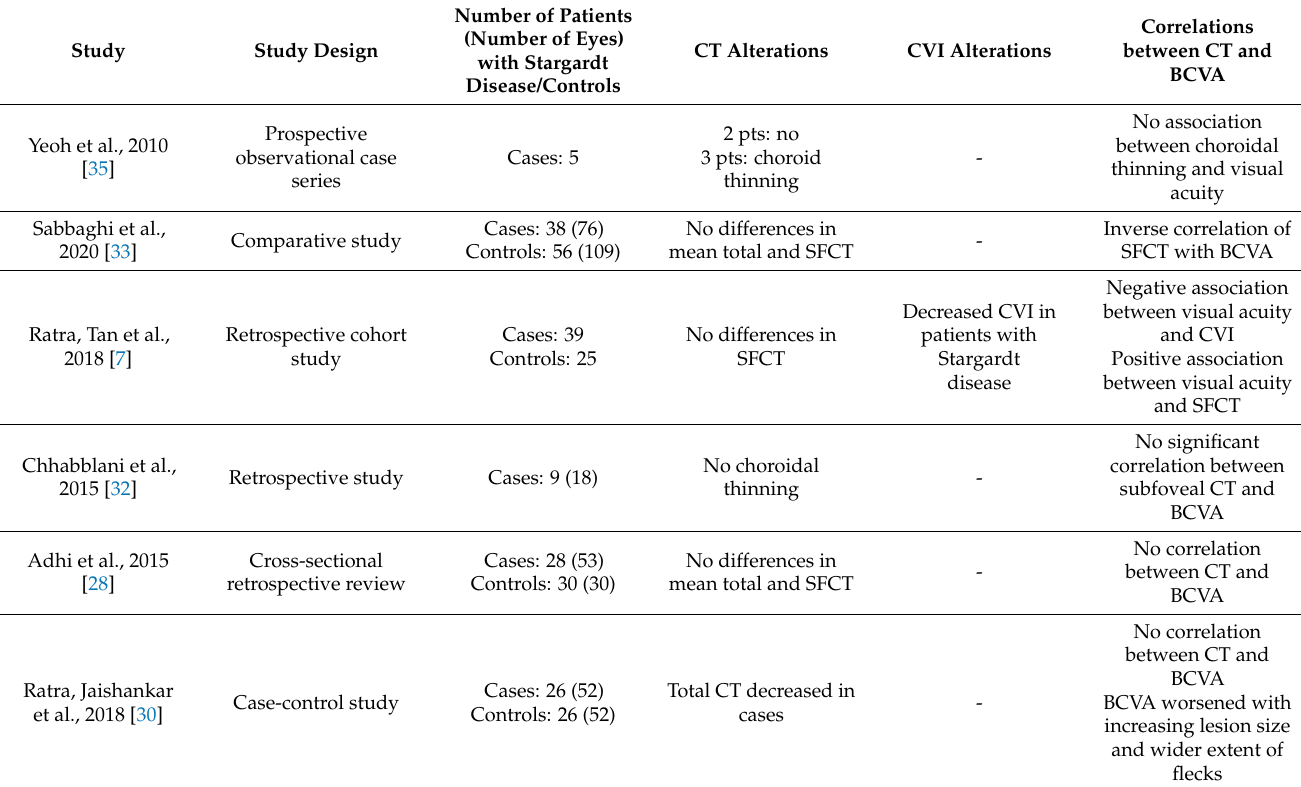
Table 1. Clinical characteristics of studies analyzing choroidal thickness and vascularity alterations in patients with Stargardt